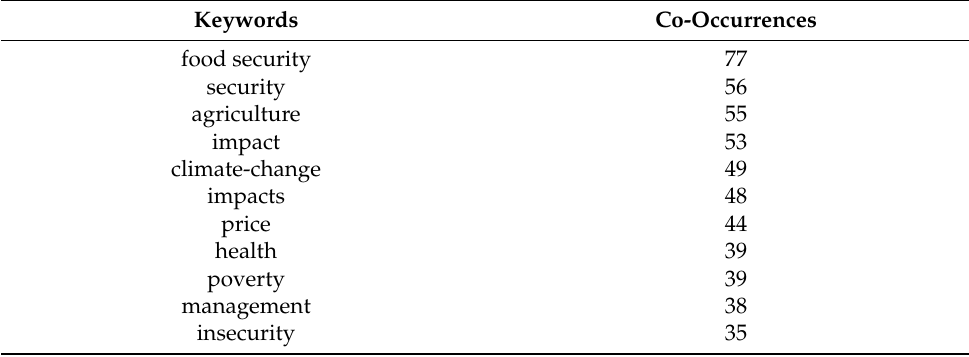
Table 8. Top ten author keywords and their